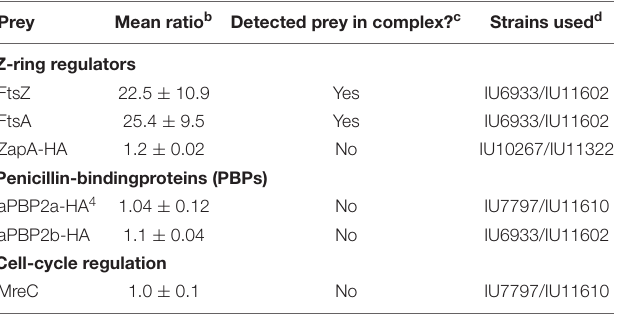
TABLE 2 | Co-immunoprecipitation of complexes containing EzrA-FLAG 3 from cross-linked Spn cells a . Prey Mean ratio b Detected prey in complex? c